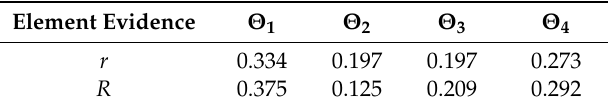
Table 5. Evidence fusion results.